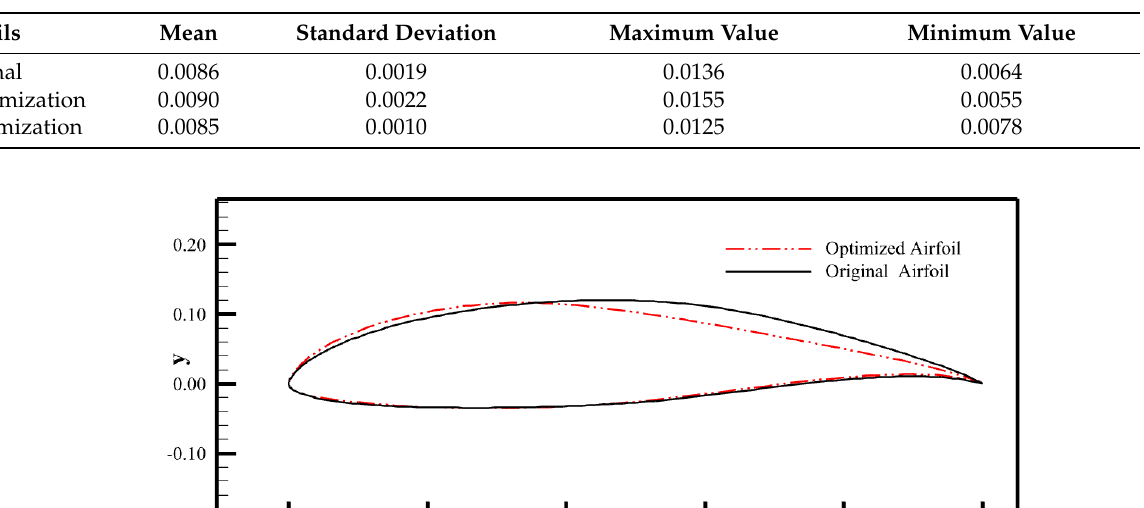
Table 4. Comparison of optimization results.